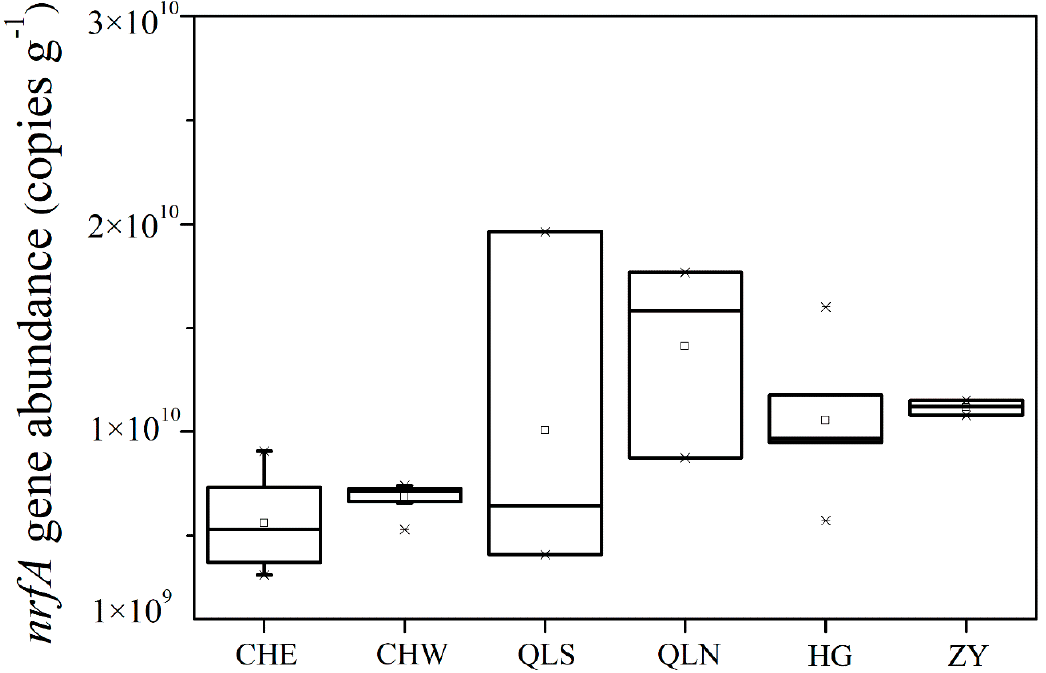
Figure 4. Boxplots showed the abundance of the nrfA gene in the sediments of the east (CHE) and west basins (CHW) of Lake Chaohu, south (QLS) and north (QLN) basins of Lake Qingling, Lake Houguan (HG), and Lake Zhiyin (ZY). Horizontal lines indicate the median, small squares show the mean, asterisks indicate the outliers, the boxes give the 25th and 75th percentiles, and bars show the range from the 5th to 95th percentiles.